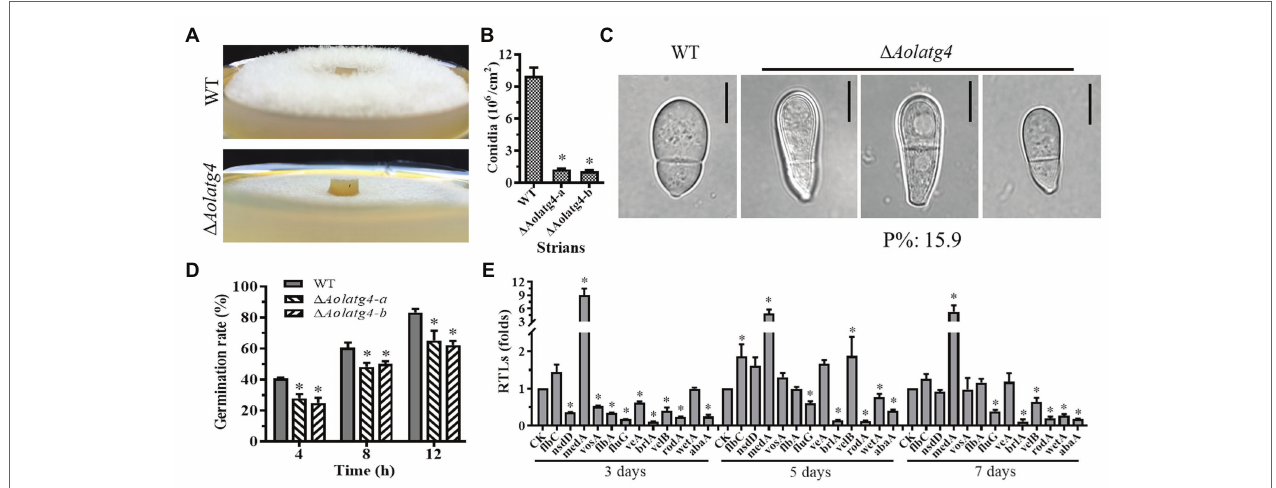
FIGURE 2 | Comparison of aerial hyphae, conidiation, and the transcript of sporulation-related genes between the WT and Δ Aolatg4 mutants. (A) Comparison of aerial hyphae between the WT and Δ Aolatg4 mutants; the fungal strains were incubated on CMY for 7 days at 28 ° C. (B) The conidia yields collected from strains grown in CMY for 7 days. (C) The conidia of the WT and Δ Aolatg4 mutants. P%: the percentage of the deformed spores in the mutant. (D) Spores of fungal strains germinate; the spores of the WT and Δ Aolatg4 mutants were incubated in MM-N liquid medium for 4, 8, and 12 h. (E) Comparison of sporulation-related genes between the WT and Δ Aolatg4 mutants. CK was denoted as a standard for statistical analysis of the RTL. Each experiment was performed three times. Error bars: standard deviation, asterisk: significant difference between mutant and WT (Tukey’s HSD, p <